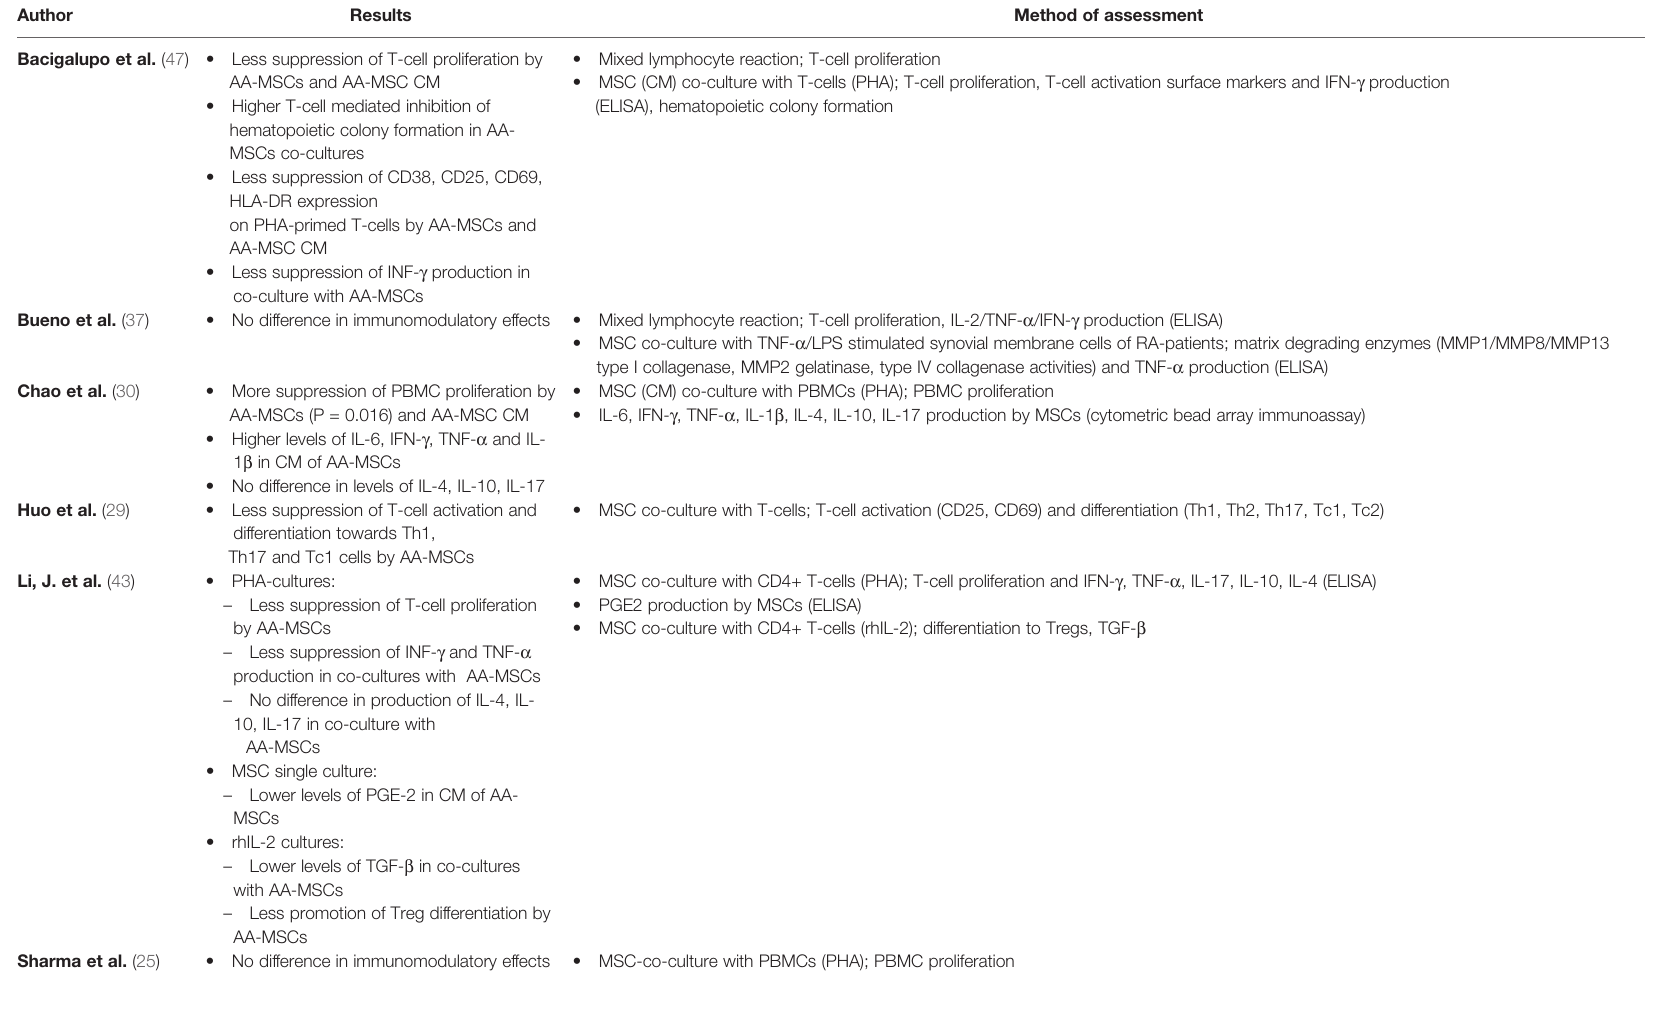
TABLE 8 | Assessment of immunomodulatory